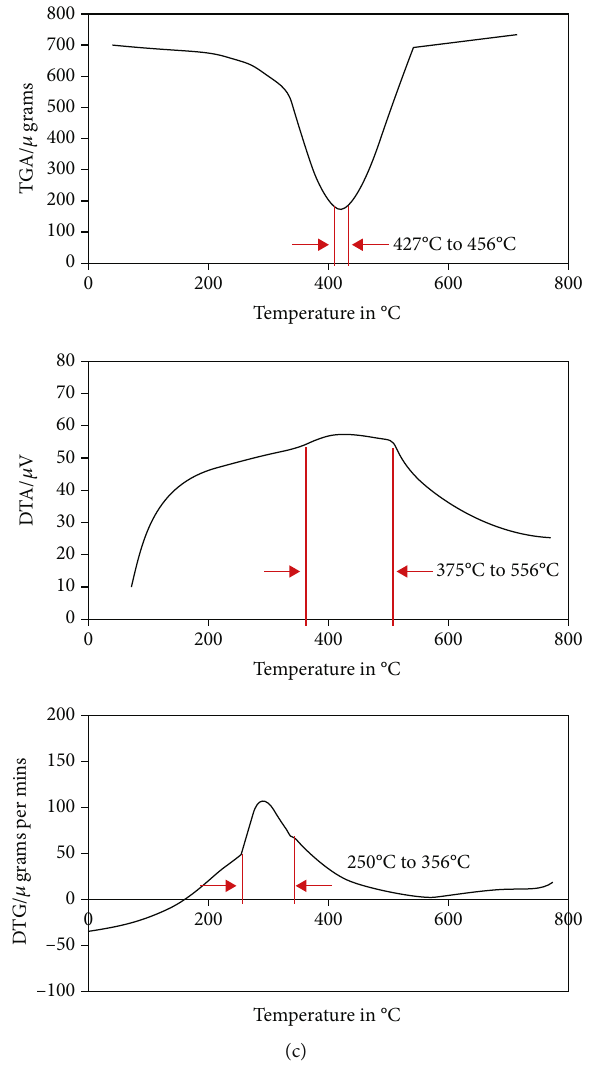
Figure 4: (a) Thermal adsorption e ff ect on TGA, DTA, and DTG results for sample 1. (b) Thermal adsorption e ff ect on TGA, DTA, and DTG results for sample 2. (c) Thermal adsorption e ff ect on TGA, DTA, and DTG results for sample